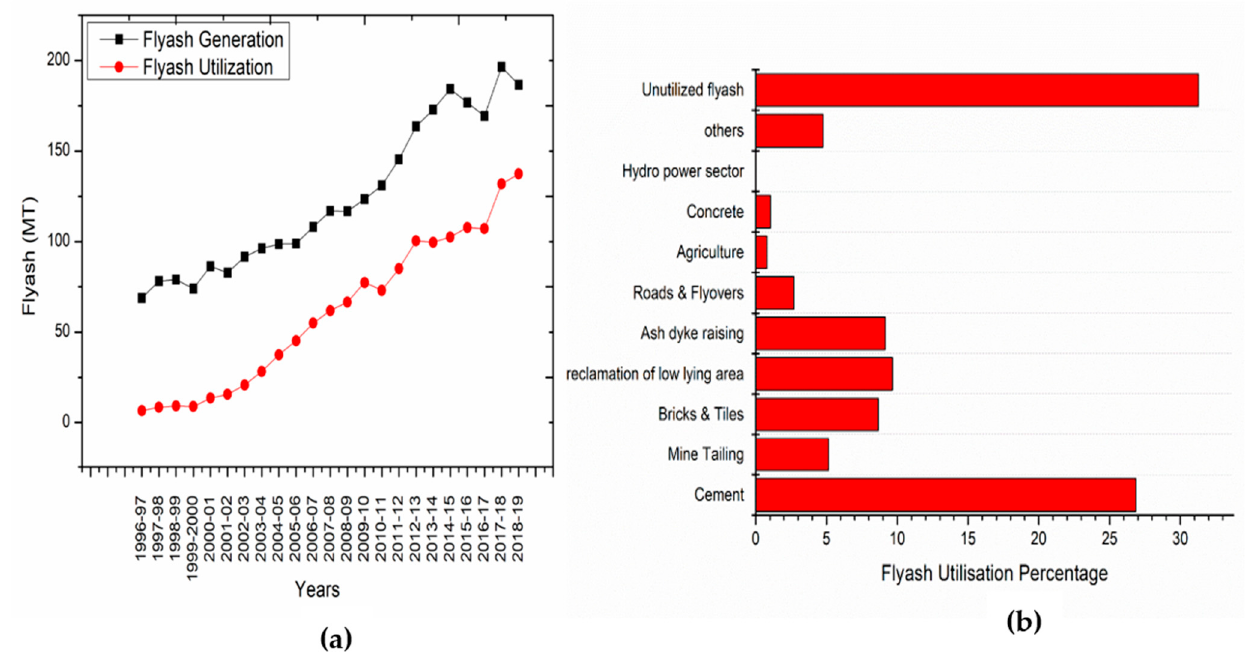
Figure 1. ( a ) Fly ash generation and utilisation in India 1996–2019; ( b ) Utilisation of the fly ash in various in India 2019 [6] .